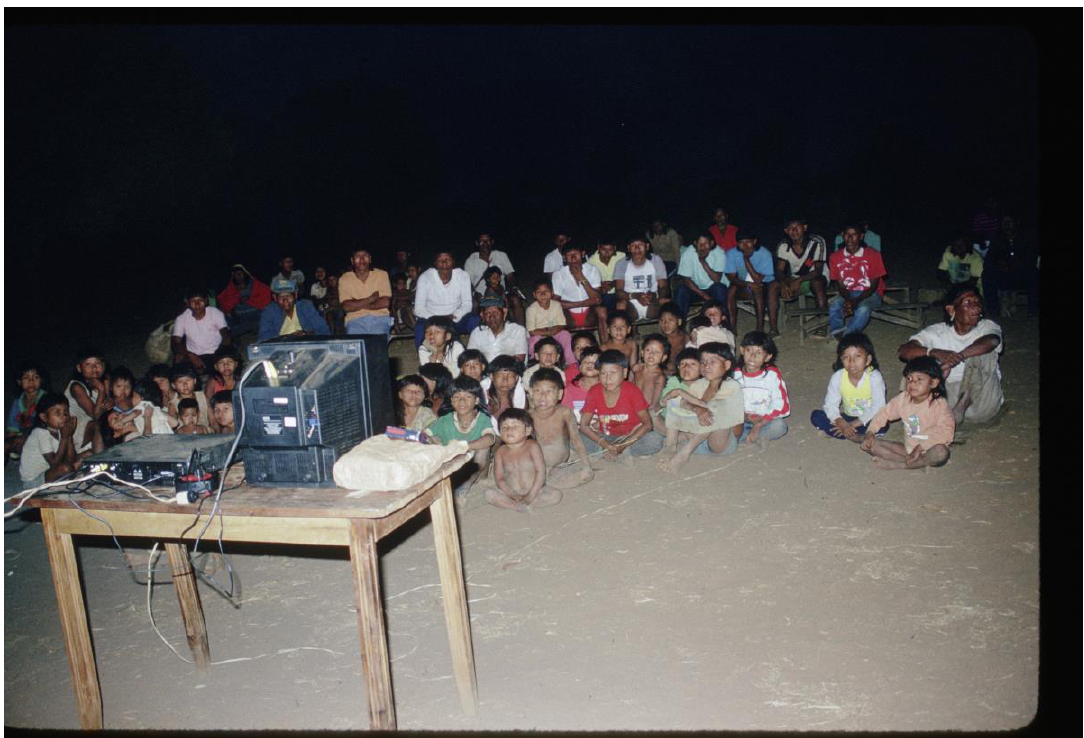
Figure 3 . Watching the first videos in the warã central plaza. Source: Photo courtesy of Laura R. Graham